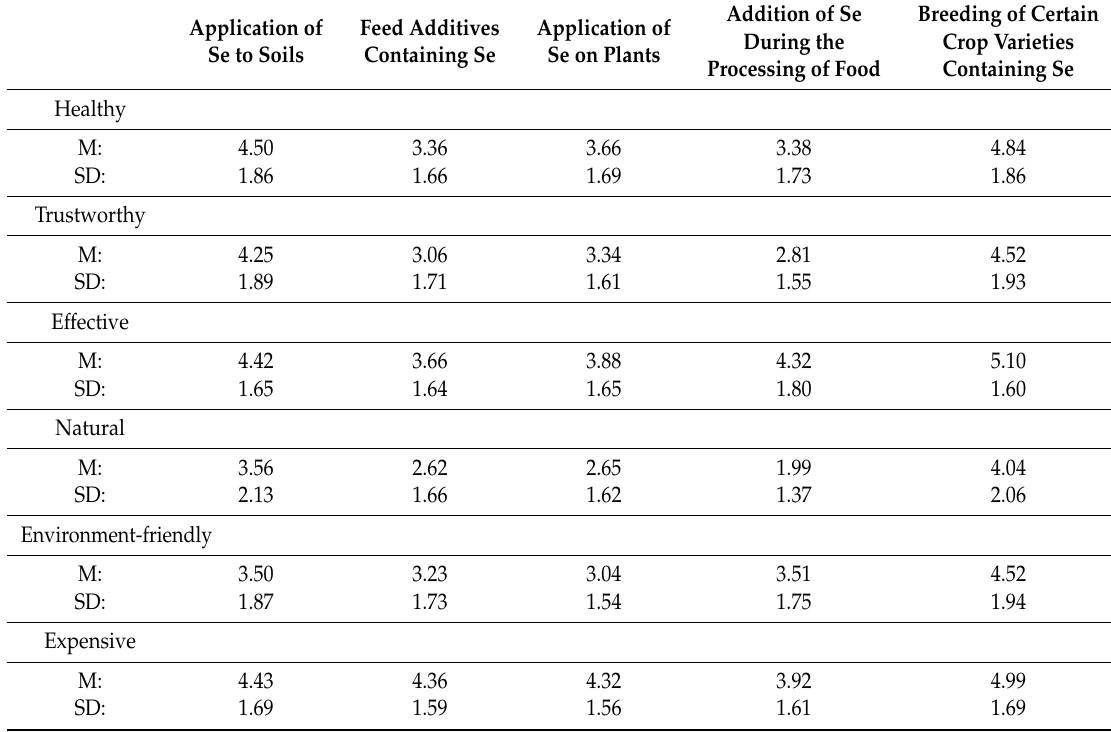
Table A2. Evaluation of different methods to increase the Se content in